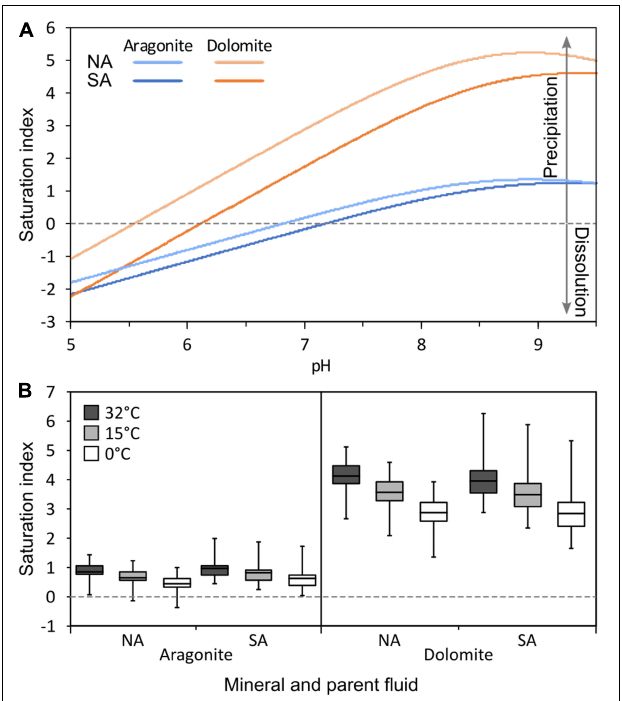
FIGURE 6 | (A) Calculated saturation states of aragonite and dolomite as functions of pH in the North Arm (NA) and South Arm (SA) of Great Salt Lake (GSL) as modeled by PHREEQc using chemical data from the 1966–2016 GSL Brine Database (Rupke and Mcdonald, 2012). (B) Historical maximum, minimum, and average saturation states of aragonite and dolomite calculated at maximum (32 ◦ C), minimum (0 ◦ C), and average (15 ◦ C) temperatures for the NA and SA of GSL modeled by PHREEQc using bulk water column solute data from the 1966–2016 GSL Brine Database (Rupke and Mcdonald, 2012). In A , note that aragonite is undersaturated (i.e., aragonite dissolution is favored) with respect to aqueous solute composition in solutions with pH < 7.0 in both the NA and SA, while dolomite remains saturated (i.e., dolomite precipitation is favored) in solutions with pH > 5.5 in the NA and pH > 6.0 in the SA. In B , note that aragonite only becomes undersaturated under extreme conditions (minimum alkalinity and low temperatures), while dolomite remains saturated under all observed conditions. Values plotted in A are presented in Supplementary Table S5 and values plotted in B are presented in Supplementary Table S3 .